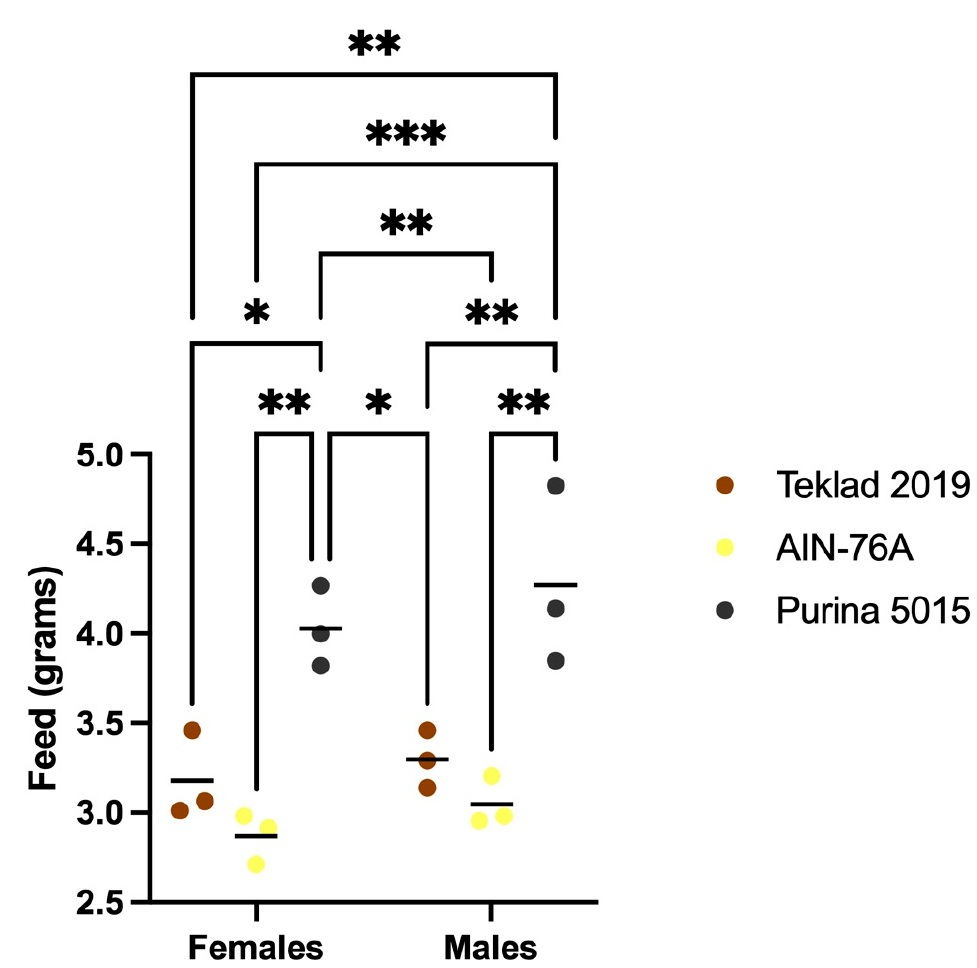
Figure 3. Mouse feed intake as an effect of diet. 2–3 mice of the same sex were housed per cage. Feed was weighed, added to the cage, and weighed again 4 days later. The average feed intake per mouse per day was plotted versus sex. Statistics were determined by 2-way ANOVA and Tukey’s multiple comparison tests denoted by p < 0.05 (*), p < 0.01 (**) and p < 0.001 (***). ANOVA results: interaction F(2, 12) = 0.0806, p = 0.92; sex F(1, 12) = 2.042, p = 0.18; and diet F(2, 12) = 32.75, p <